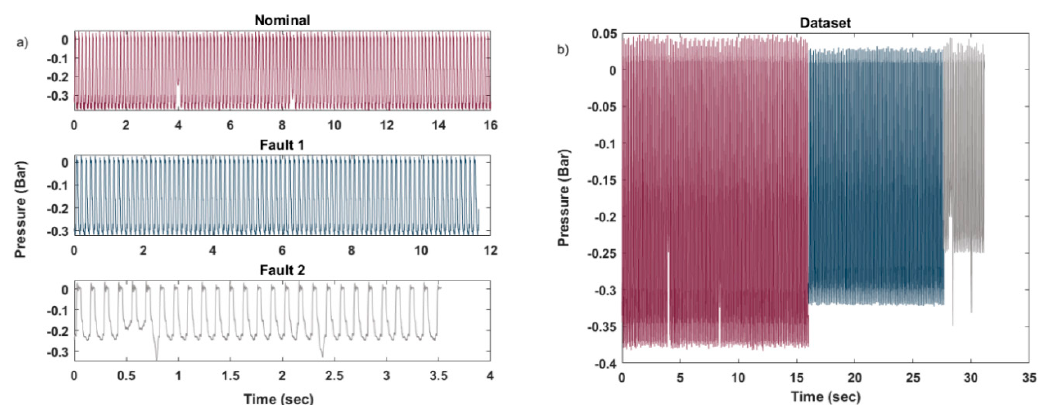
Figure 7. ( a ) Signals related to three different conditions. ( b ) Complete dataset containing all